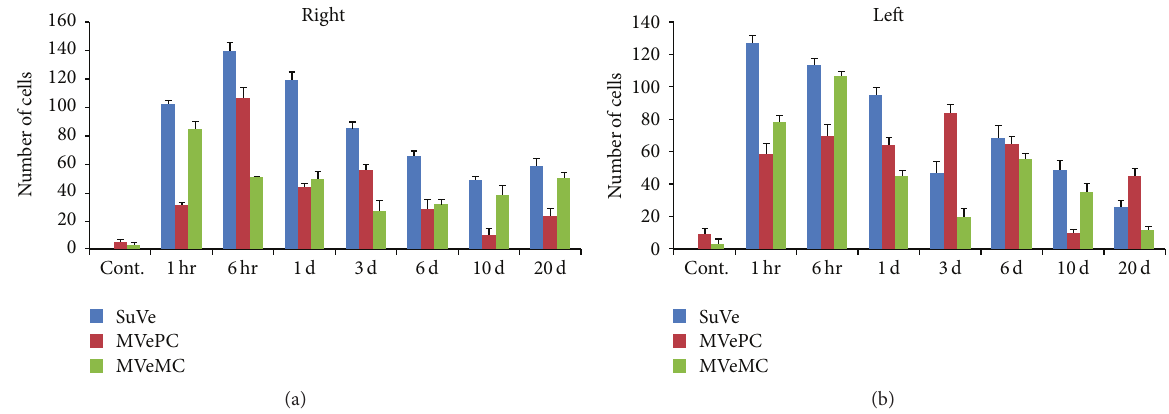
Figure 10: Cell counts of c-Fos-positive cells in SuVe, MVePC, and MVeMC after cochleostomy. Increased c-Fos-positive cells were observed in the bilateral vestibular nucleus, including SuVe, MVePC, and MVeMC, after cochleostomy relative to normal controls; this increased immunoreactivity was sustained until 1 day after cochleostomy and then declined slightly over time. Changes in immunoreactivity in SuVe were more marked compared to MVePC and